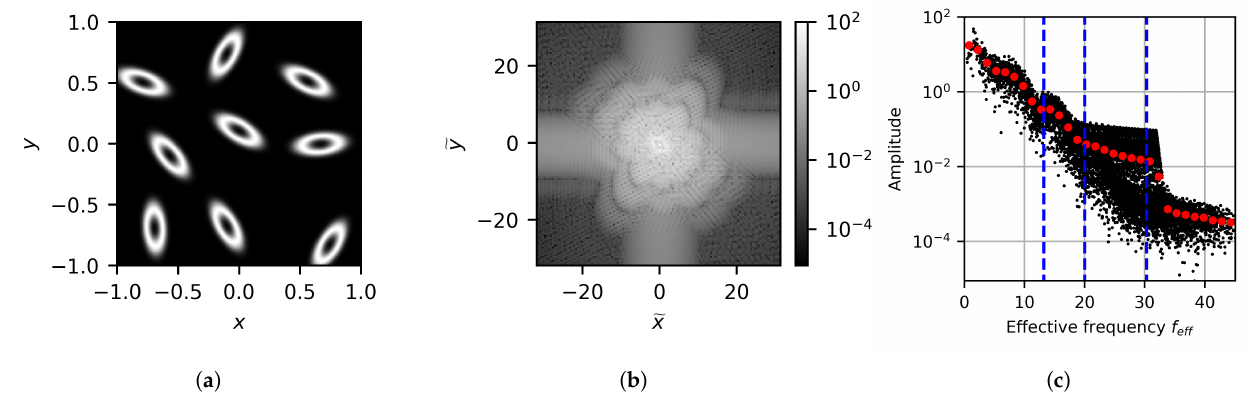
Figure 12. Image processing output for the elliptical interface case showing ( a ) the generated image, ( b ) the FFT data, and ( c ) the FFT data projected onto the effective frequency